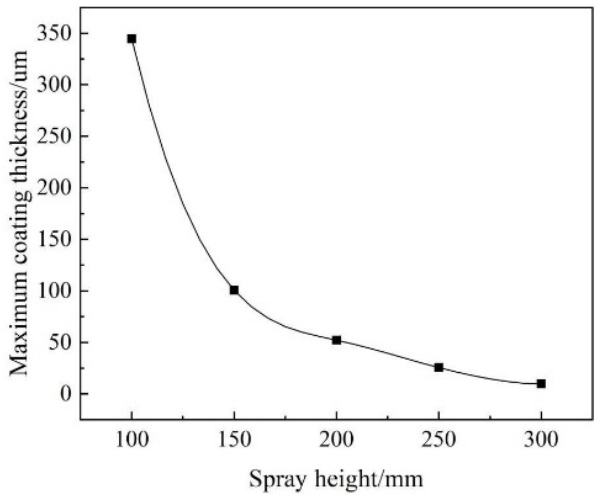
Figure 11. The law of maximum coating film thickness varying with spray height.